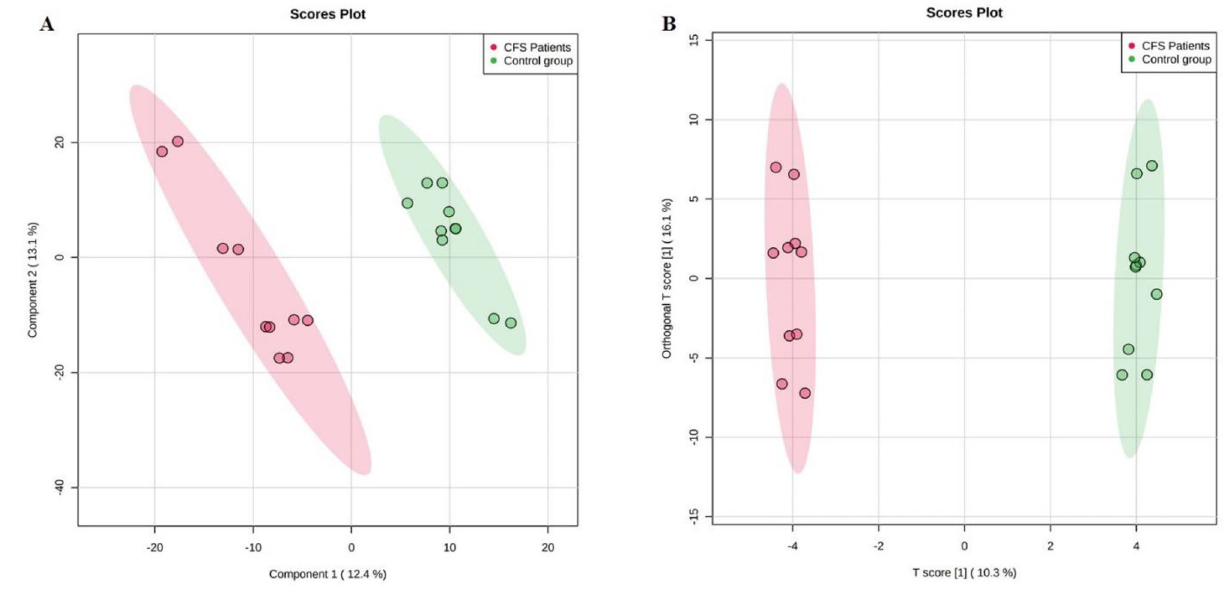
Figure 6. ( A ) PLS-DA and ( B ) OPLS-DA supervised models for the classification of the experimental groups (CFS patients vs controls). In the score plot of OPLS-DA, the x-axis represents the biological component and the y-axis the orthogonal